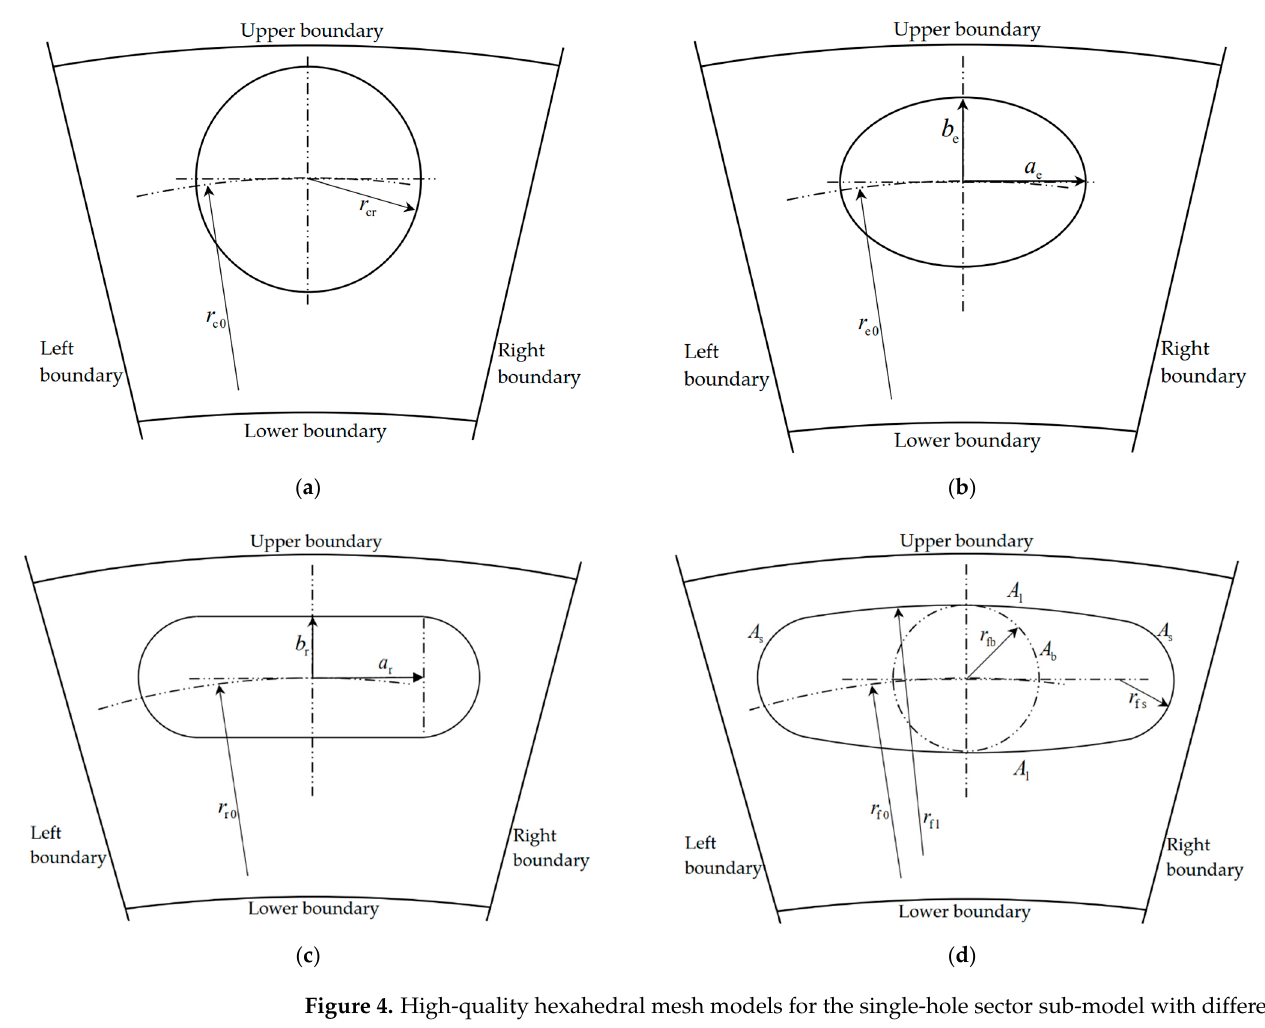
Figure 4. Schematics of four different shape designs for the vent hole. ( a ) Circular hole; ( b ) Elliptical Figure 4. High-quality hexahedral mesh models for the single-hole sector sub-model with different hole; ( c ) Race-track hole; and ( d ) Four-arc hole. shapes of vent holes.